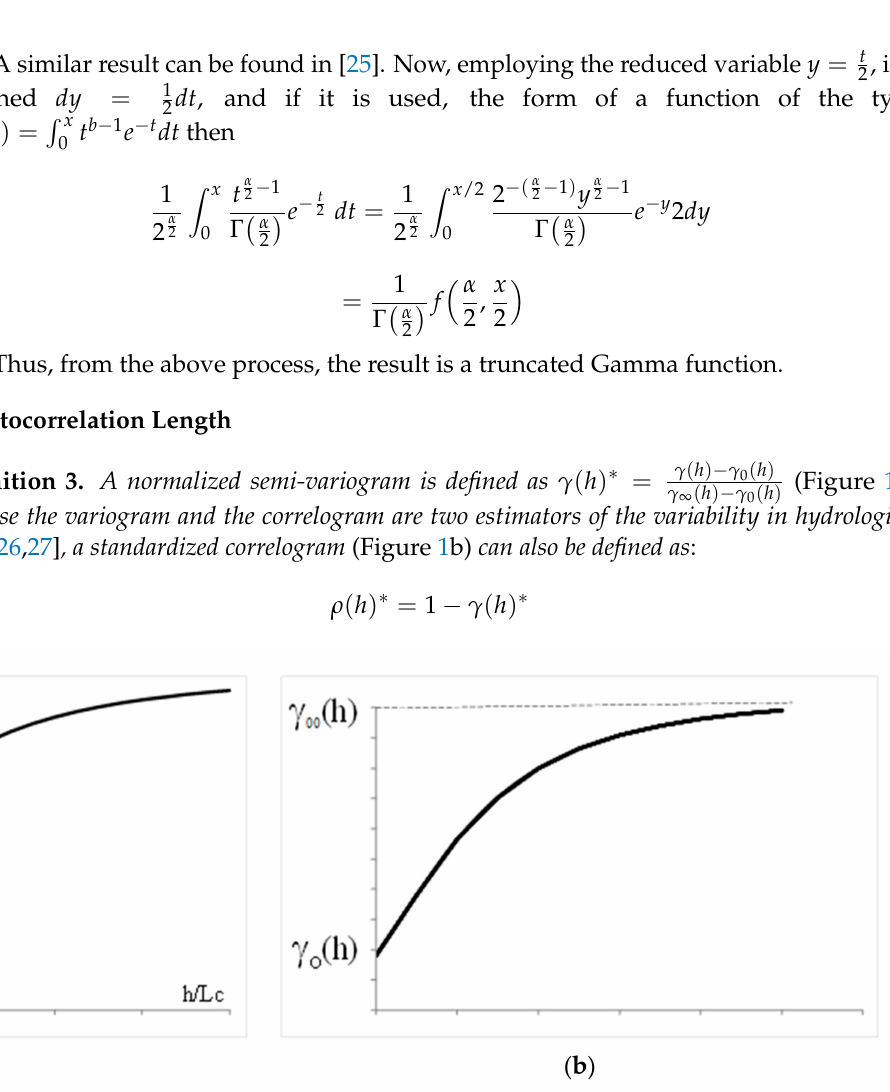
Figure 1. ( a ) A standard variogram; ( b ) a normalized